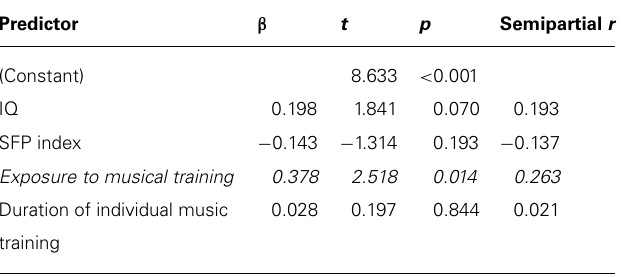
Table 3 | Regression model predicting performance on the distorted tunes test.